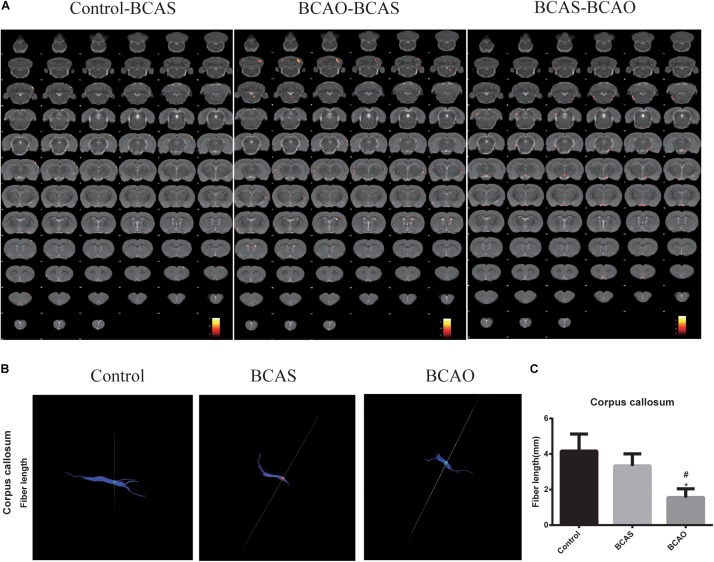
(A) Voxel-based statistical analysis of the diffusion tensor imaging parameter FA. (B,C) The change of white matter neural fiber (B) and fiber length in corpus callosum. The significant main effects of the phenotype are shown for the mean diffusivity. Results are displayed on an anatomical template with a visualization threshold of false discovery rate with P < 0.005 and a minimum cluster size of 20 voxels. The color scale indicates f-values, with yellow indicating a larger difference between the conditions investigated. Control-BCAS means that the FA value in BCAS rats is lower than in controls. BCAS-BCAO means that the FA value in BCAS rats is higher than in BCAO rats. The strongest effects according to the voxel-based analysis are displayed in the graphs. Data are expressed as the mean ± SD (n = 6/group). ∗P < 0.05 compared with the control group; #P < 0.05 compared with the BCAS group. FA, fractional anisotropy; BCAS, bilateral common carotid artery stenosis; BCAO, bilateral common carotid artery occlusion; SD, standard deviation.